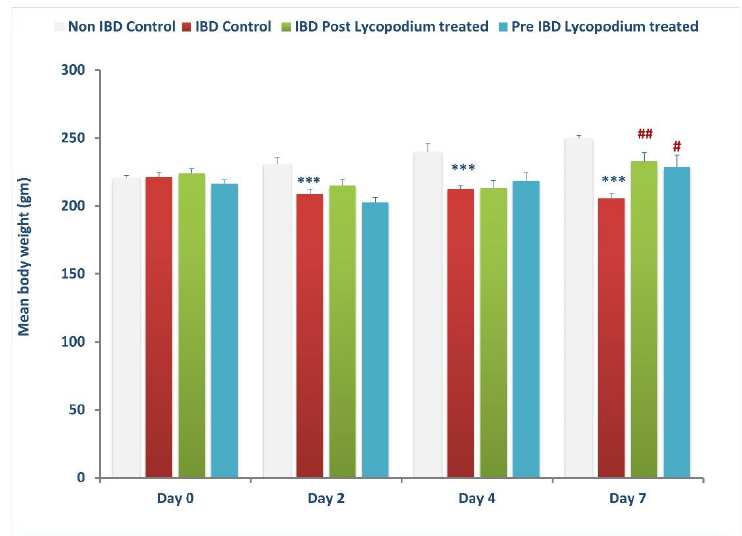
Figure 2. Effect of lycopodium on mean body weight. *** p < 0.001 vs. non IBD control group; # p < 0.05, ## p < 0.01 vs. relative IBD control group.